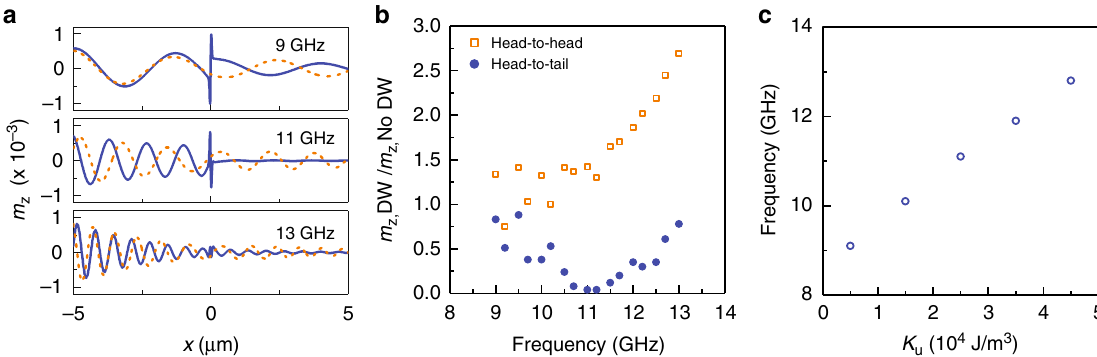
Fig. 5 Dependence of spin-wave transmission on frequency and anisotropy strength. a Micromagnetic simulations of spin-wave transport through a broad 90° head-to-head domain wall (dashed orange line) and a narrow 90° head-to-tail domain wall (solid blue line) at three different frequencies. b Frequency dependence of the spin-wave amplitude after passing through a head-to-head and head-to-tail domain wall. The amplitude is normalized to simulation data for a fi lm without a domain wall. c Frequency of minimal spin-wave transmission through a head-to-tail domain wall as a function of magnetic anisotropy strength NATURE COMMUNICATIONS| (2018) 9:4853 |DOI: